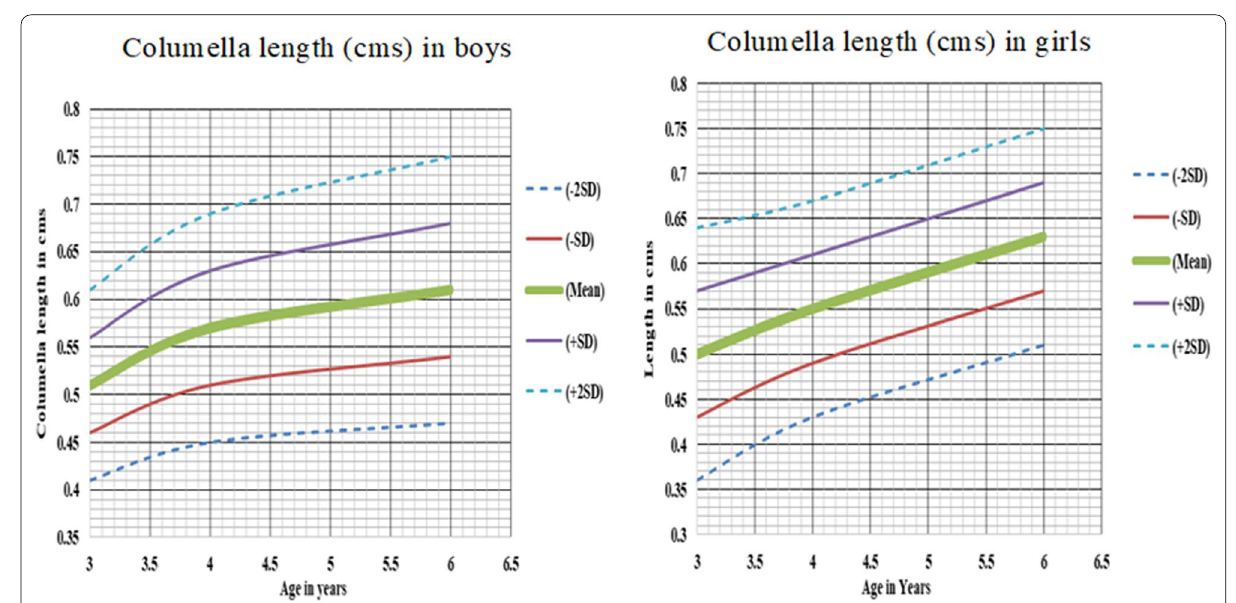
In the present study, eye measurements in the partici- pating children aged from 3 to 6 years showed no signif- icant difference; p > 0.05. Mean values of inner canthus distance (ICD) ranged from 2.8 to cm. The mean of outer canthal distance (OCD) ranged from 7.6 to 8.2 cm and that of inter-pupillary distance (IPD)